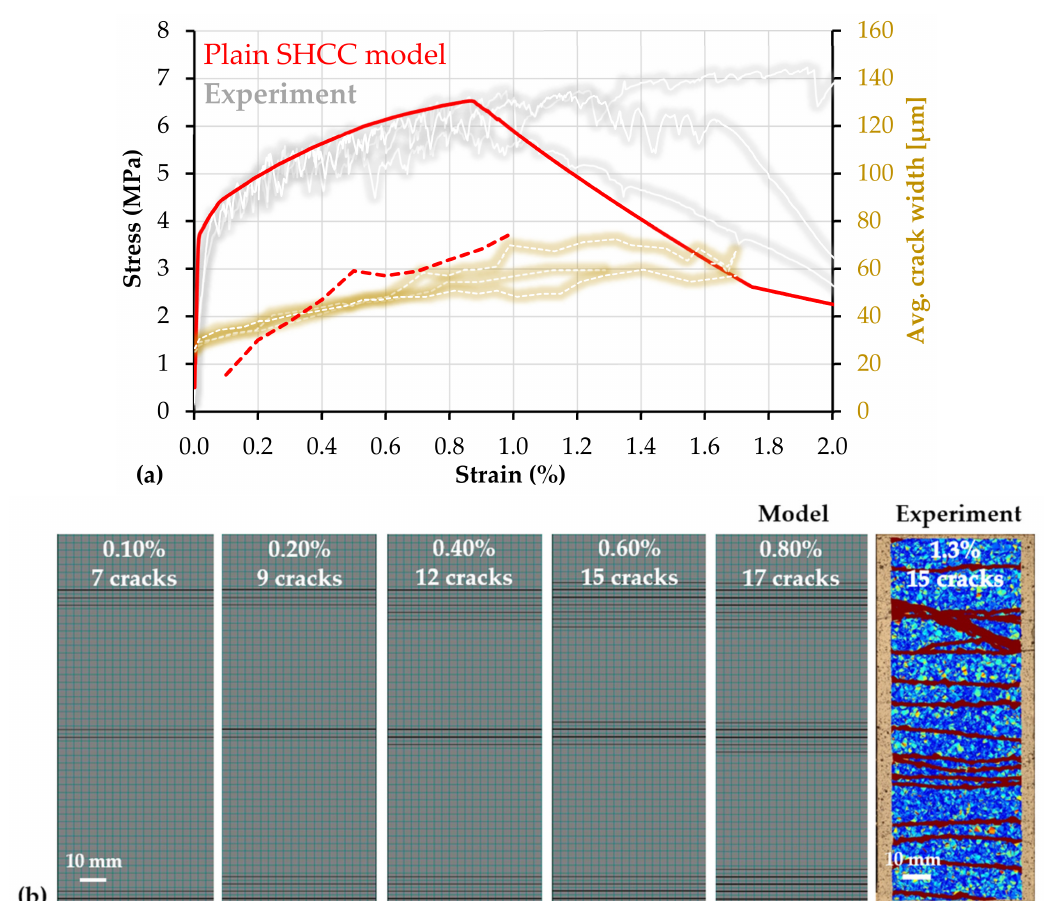
Figure 12. ( a ) Macroscopic stress–strain curve (continuous) and average crack widths (dashed) of the reference SHCC model composite with experimental results adopted from [13]; ( b ) crack pattern and sequence in the loaded SHCC model and a representative experimental crack pattern based on DIC